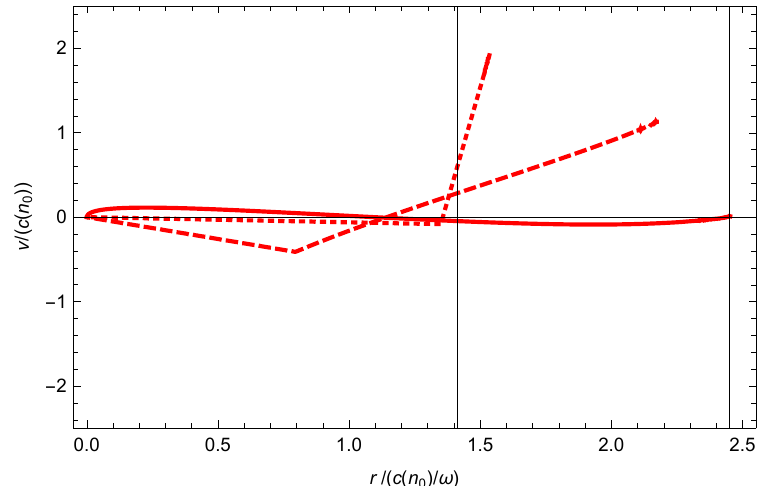
Figure 2: A two-dimensional disk-shaped quasi-breather. Shown are the density distributions at ω t = 0.0615924 (short-dashed), ω t = 0.478 (long-dashed), and (cid:112) ω t = arctan ( / 2 ≈ 0.955 (solid). Recall that the quasi-revival pe- 2 ) = ω T quasi-breathing = 2 T / 7, giving ω T (cid:48) / 2 = 0.898. riod conjectured in Ref. [ 1 ] is T (cid:48) quasi-breathing quasi-breathing Both the hydrodynamic results (red) and the ab initio Gross-Pitaevskii calculation (blue) are shown. The two thin vertical lines correspond to, from left to right, the initial ball radius and the position of the outer edge of the atomic cloud at the hydrodynamic prediction for the quasi-breathing half-period (30).